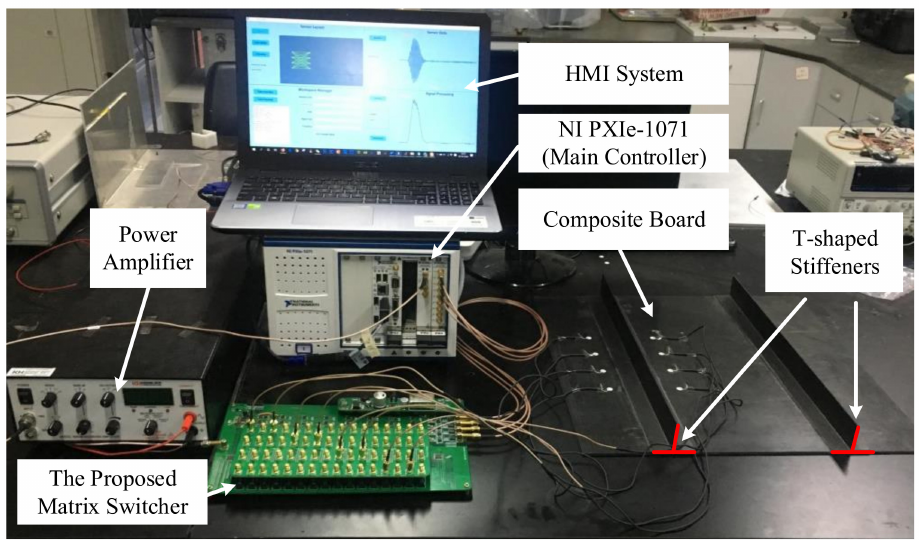
Figure 10. Experiment